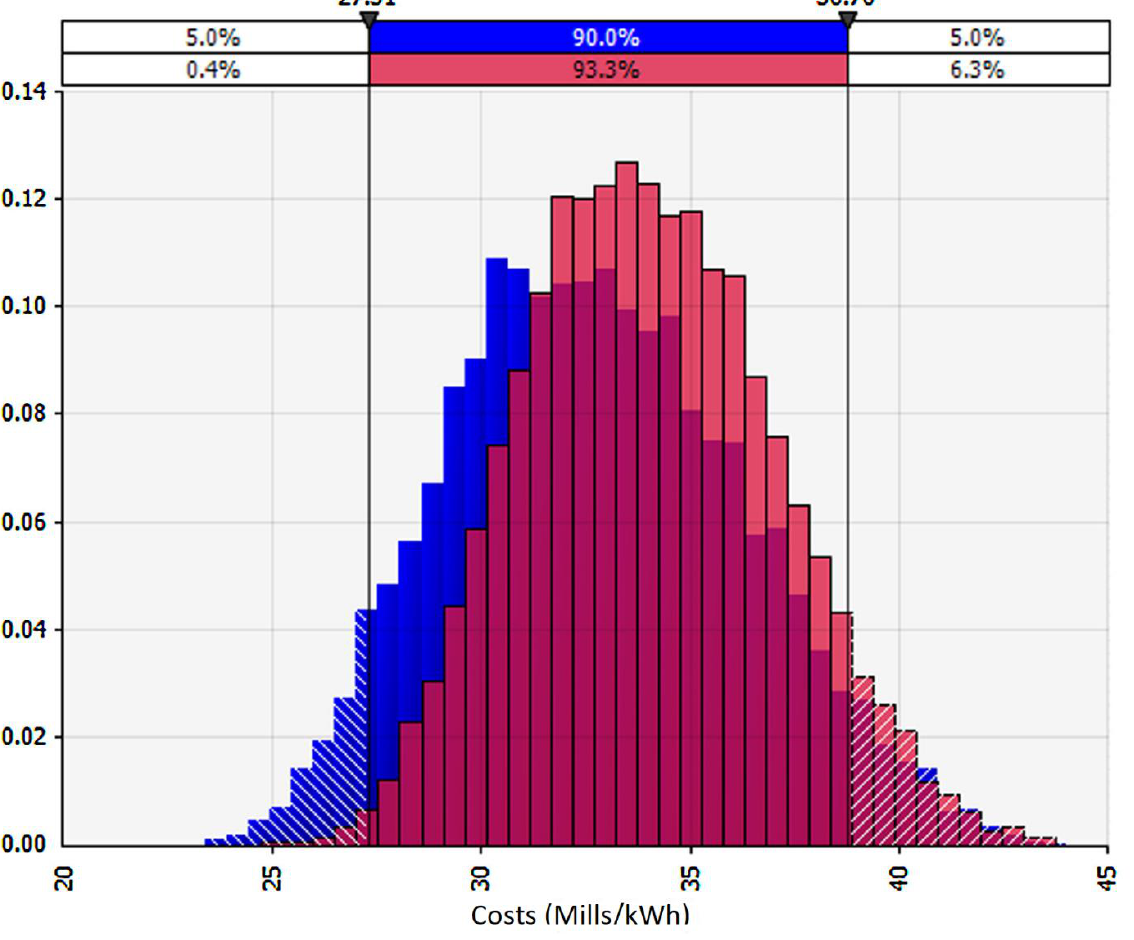
Table 10. LCOE values for the SNF management options analysed by Rodríguez-Penalonga et al. [66], calculated as a percentage relative to the costs of the OTC for 25 TWh/a generation at a 0% discount rate (reported as USD 10.65 (2010)/MWh.